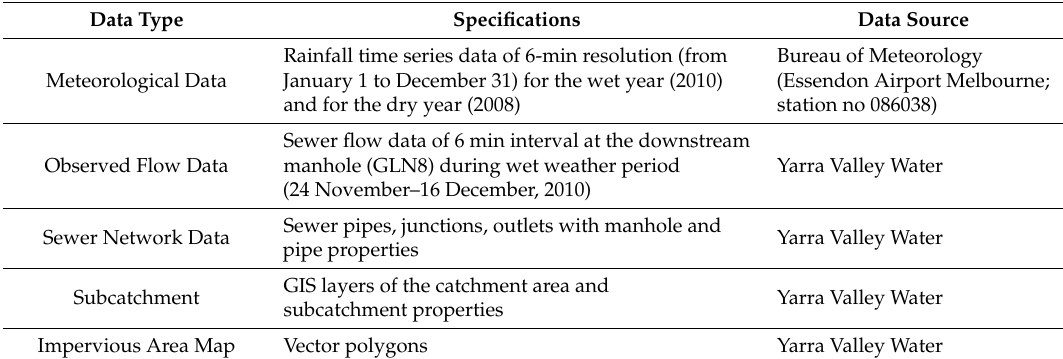
Table 1. Input data for model